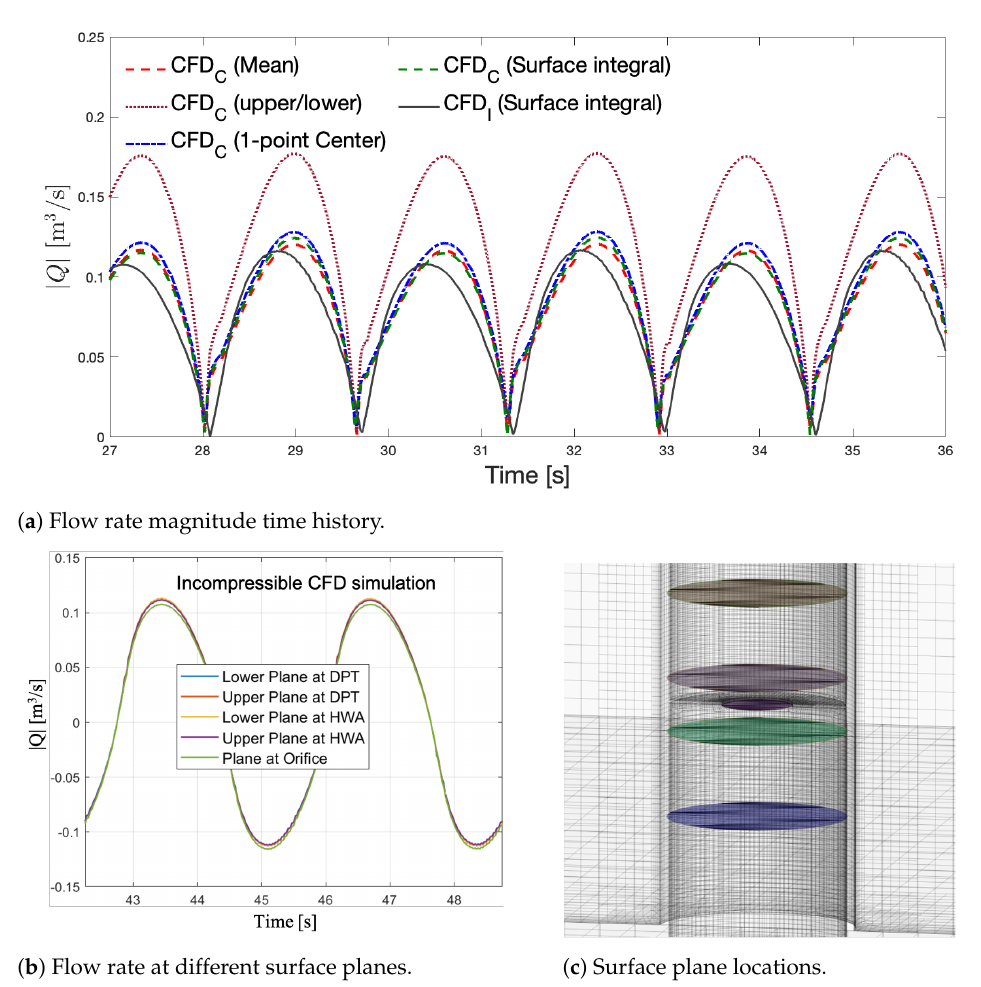
Figure 25. ( a ) Comparison of the flow rate magnitude using different methods for Test 106; ( b ) flow rate at different surface planes from the incompressible CFD simulation; and ( c ) the orientation of those surface planes inside the